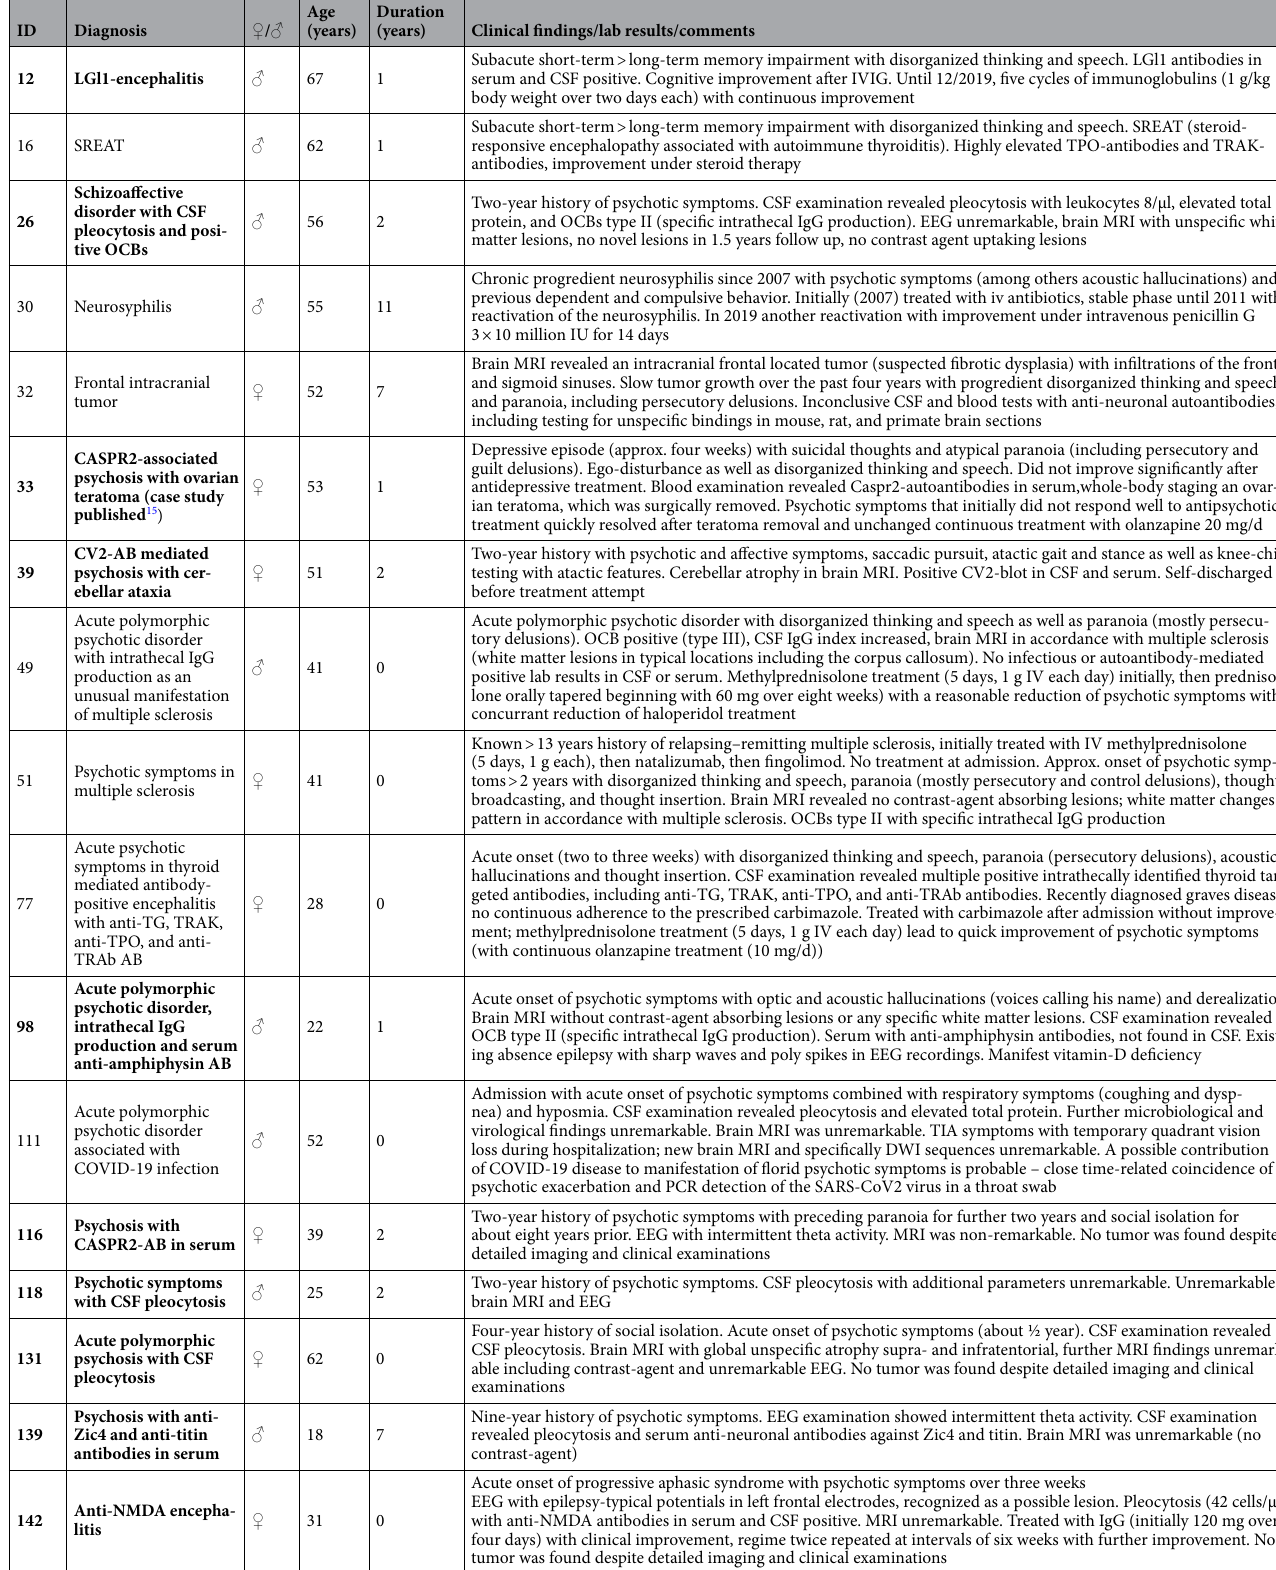
with anti-NMDA antibodies in serum and CSF positive. MRI unremarkable. Treated with IgG (initially 120 mg over four days) with clinical improvement, regime twice repeated at intervals of six weeks with further improvement. No tumor was found despite detailed imaging and clinical examinations Table 4. All cases with diagnosis of F06.2 The cases listed in bold (n = 10) are probable autoimmune psychoses according to Pollak. The non-bold cases (n = 7) are categorized as other F06.2 cases as described in the Methods Section because an attributable and explanatory process was identified. The cases are summarized with the abnormal examination reports listed above. Abbreviations: AB: antibodies, OCB: oligoclonal